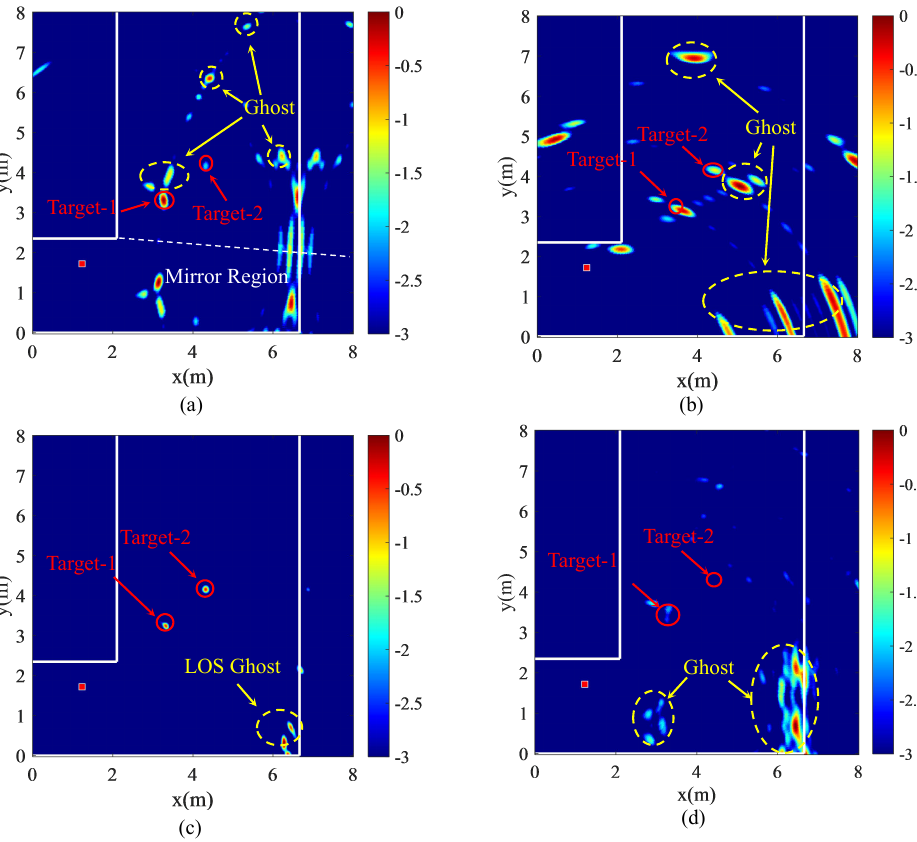
Figure 13. Multipath imaging results via dual-view in double target scenario. ( a ) Imaging result of Path -1, Path -3 and Path -5 through range profiles of View 1. ( b ) Imaging result of Path -2 and Path -6 through range profiles of View 2. ( c ) Fusion of ( a , b ). ( d ) Imaging result of previous algorithm.